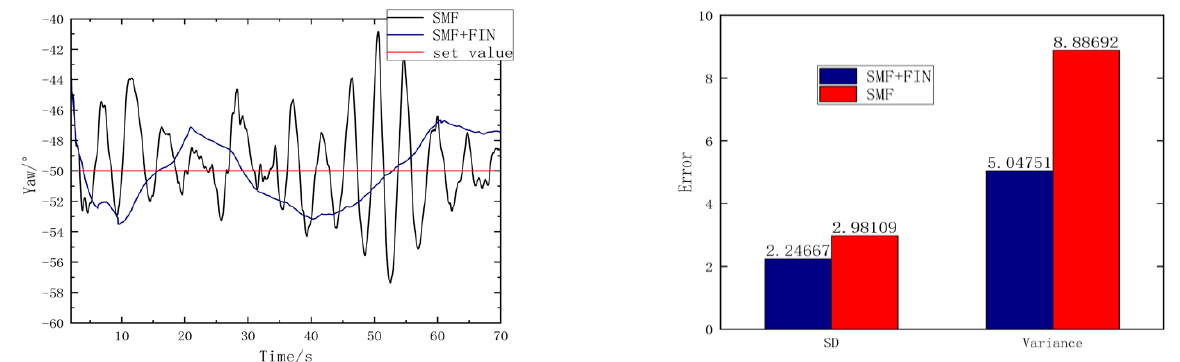
Figure 20. Yaw control result with and without fins ( left ), the stand deviation and variance ( right ).